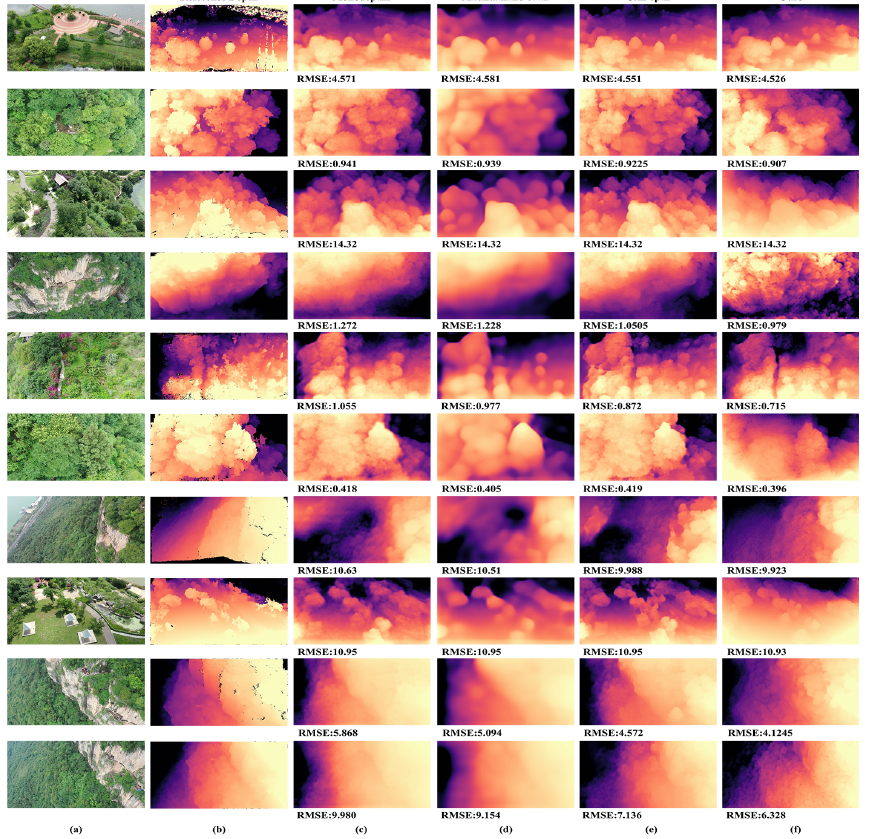
Figure 6. Qualitative comparison between ( b ) reference depths from SLAM, ( c ) Monodepth2